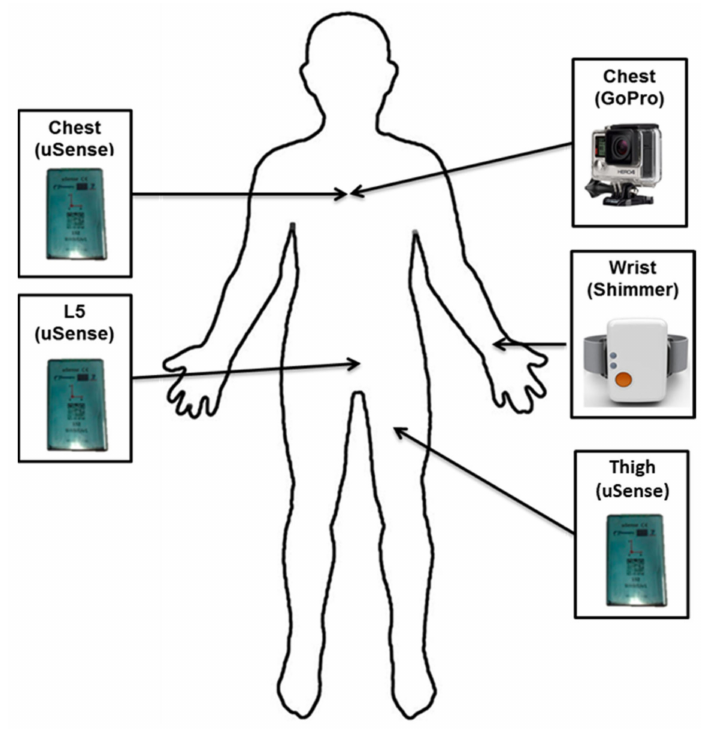
Figure 1. Set of IMU sensors analysed from ADAPT